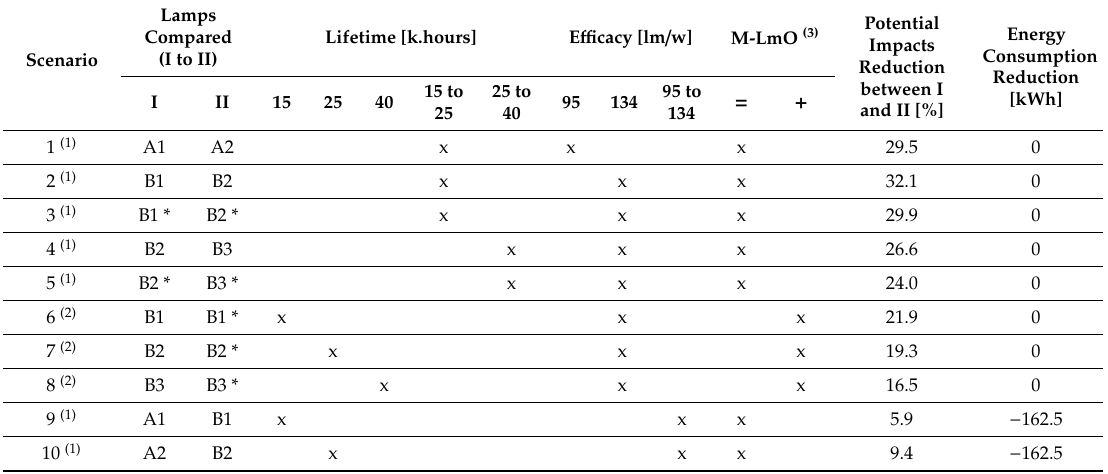
Table 7. Reduction in potential impacts and energy consumption for lamp replacement scenarios.